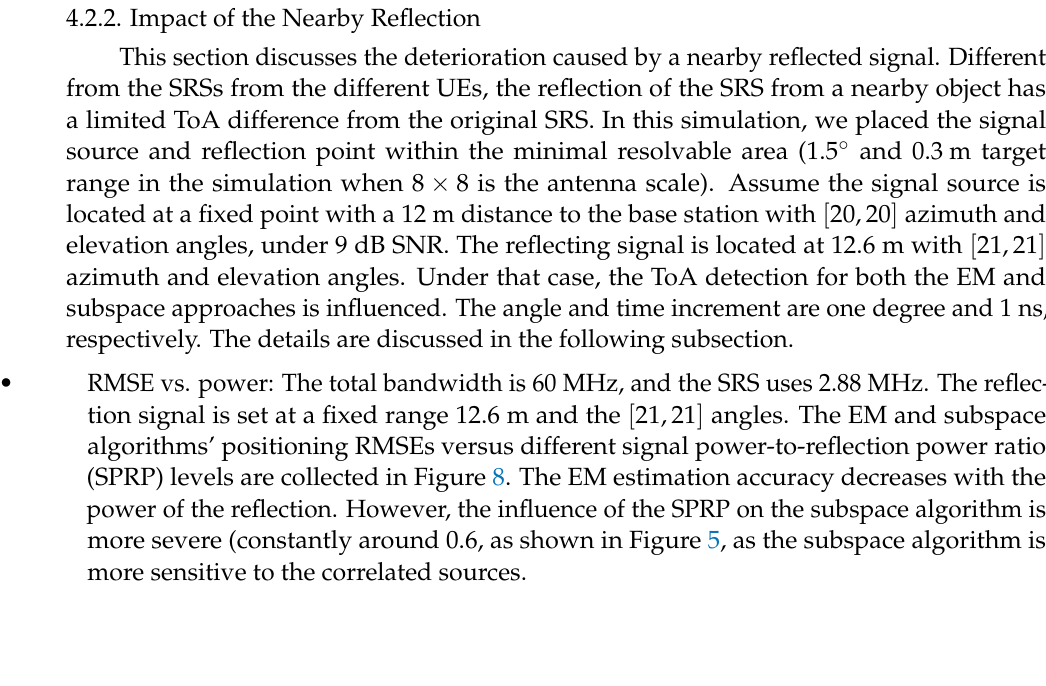
Figure 7. Positioning accuracy of the EM and subspace algorithms with different